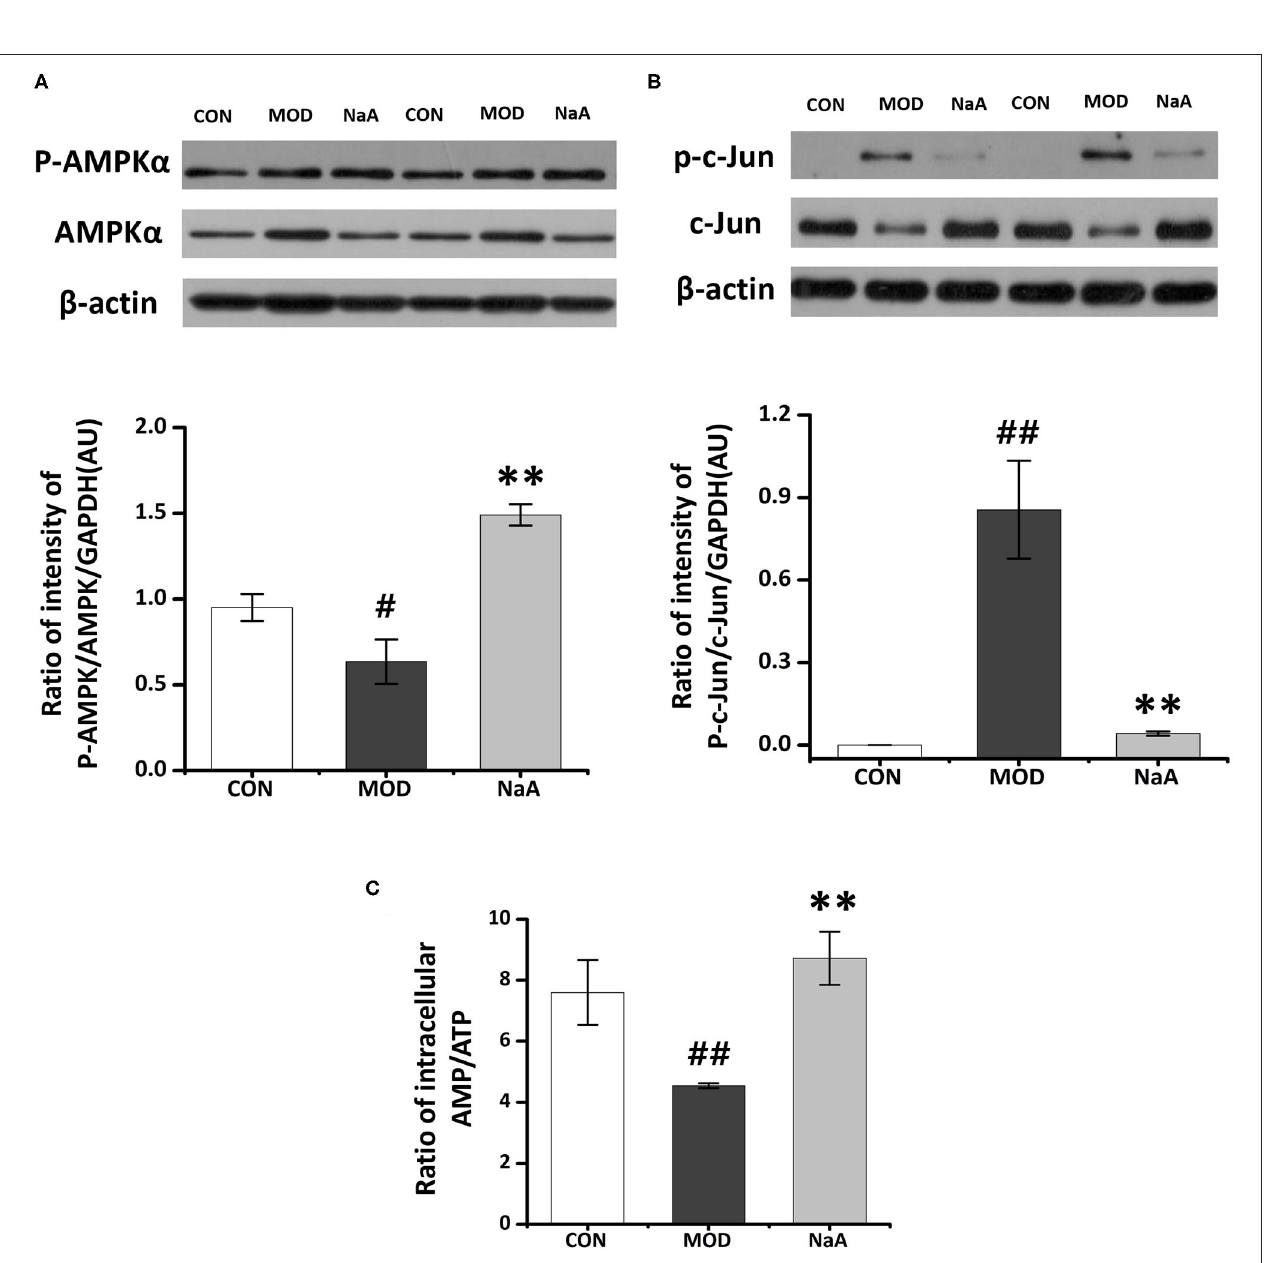
FIGURE 5 | Research on the specific mechanism of NaA on the activaon of LX2 cells. LX2 cells were treated with or without 2.5ng/ml TGF- β 1 and (0–1) mM of NaA for 48h at 24h post-transfection. (A) HPLC was used to evaluate Intracellular AMP: ATP. (B,C) Western blot was used to evaluate phosphorylation of AMPK α and c-Jun. LX2 cells were treated as detailed in the section Materials and Methods. For all bar graphs, data are the mean ± SD, # p < 0.05, ## p < 0.01, as compared with CON, and ** p < 0.01, as compared with MOD. The significant difference was assessed using the one-way ANOVA followed by LSD post-tests. Control group (CON), group model cell treated with a TGF- β 1 (MOD), sodium acetate (NaA), arbitrary unit (AU).